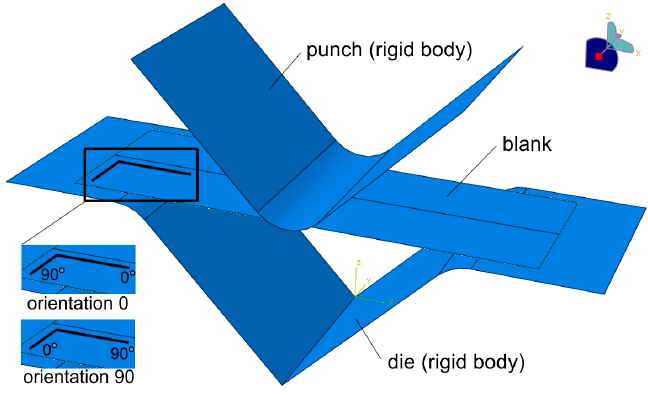
Figure 4. Boundary conditions in V-bending model of the sample cut along the sheet rolling direction.